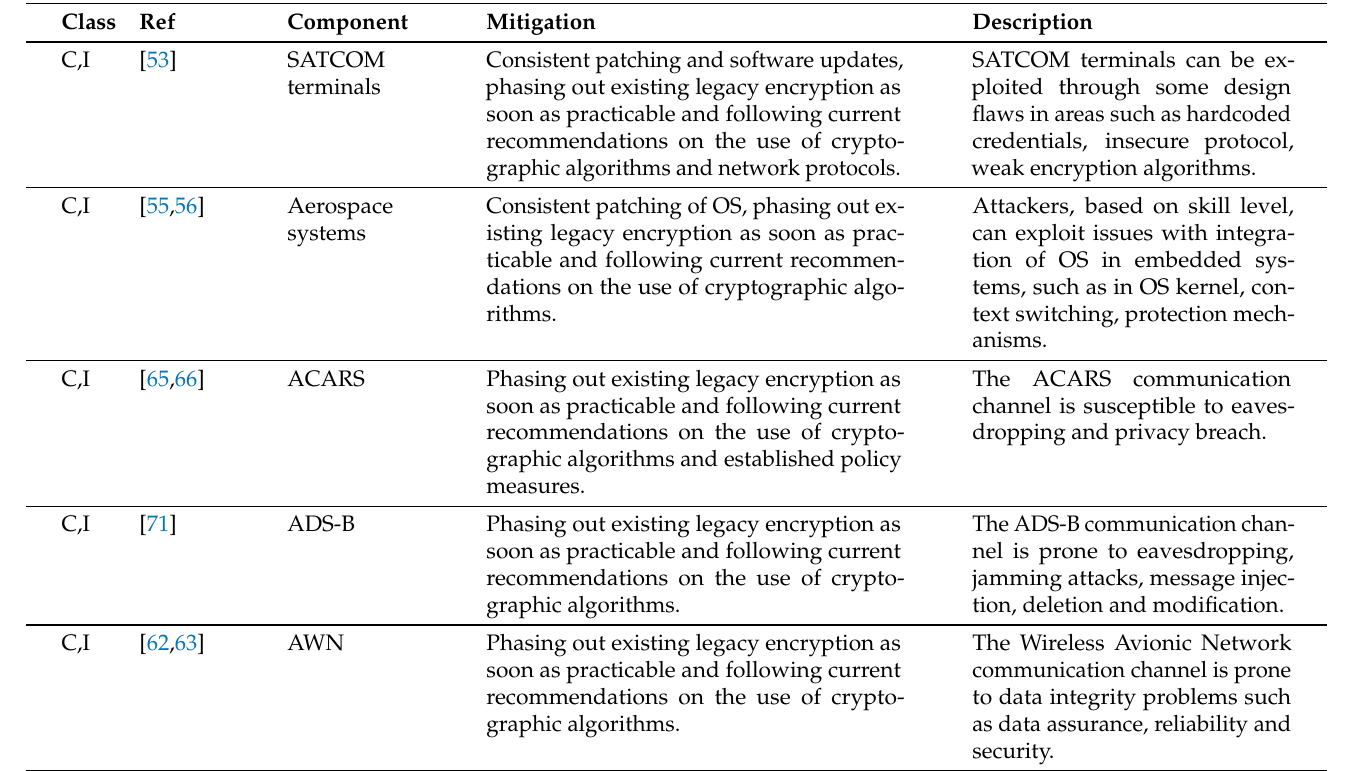
Table 4. Some Exploitable Flaws and Components in the Civil Aviation